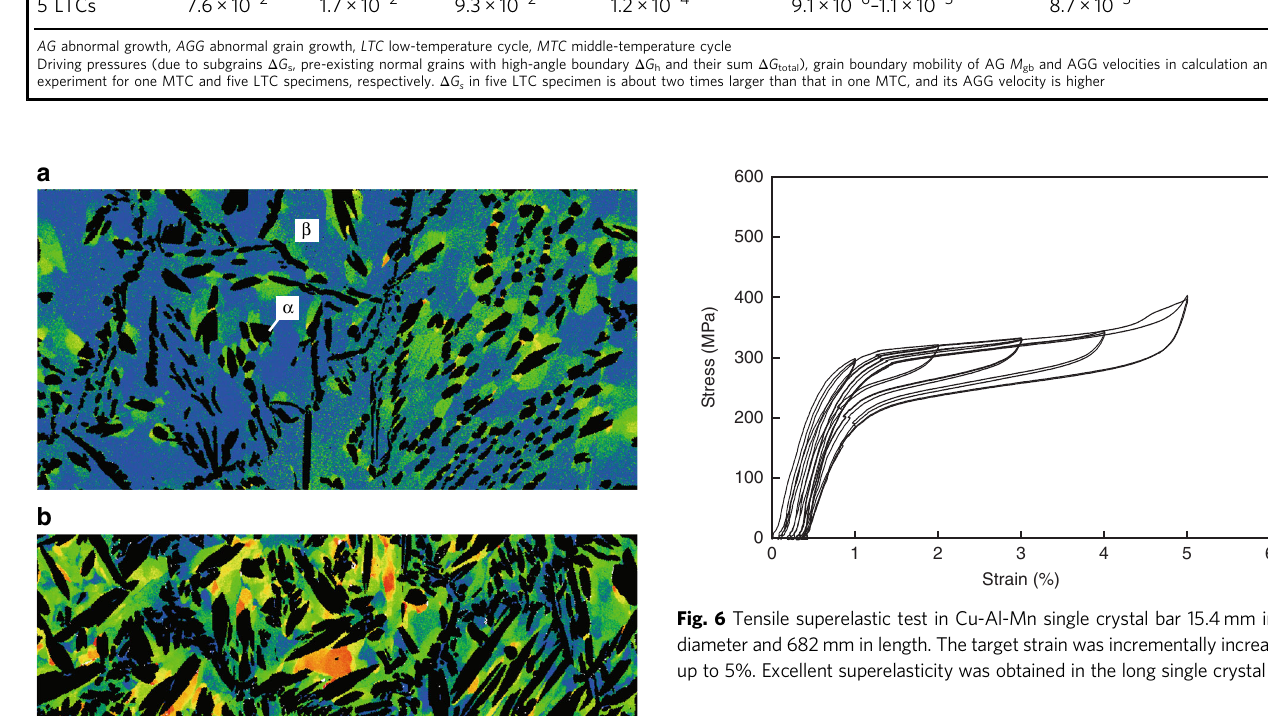
of 2mm and subsequent cold-rolling to a thickness of 1mm with intermediate annealing at 600°C. Bar specimens were obtained by hot forging and cold drawing to a diameter of 15mm. The β solidus and α solvus temperatures of this alloy were determined to be 948 and 726°C, respectively, by means of differential scanning calorimetry (DSC). The sheet specimens were solution- treated at 740 – 900°C for 5 – 15min in the β single-phase region. They were cooled to 500°C in the α + β two-phase region at a cooling rate of 3.3°Cmin − 1 and held for 10min at 500°C, and then heated to 760 – 900°C at a heating rate of 10°Cmin − 1 and held for various periods, followed by quenching in water. Some specimens were subjected to CHT between 740 and 500°C fi ve times, instead of the single CHT, before heating to the β single-phase region. The procedure of heat treatment of the bars and sheets is illustrated in Fig. 1 and Supplementary Fig. 4. Microstructural observation . The microstructure and the crystallographic features were investigated by optical microscopy and EBSD using a fi eld emission scanning electron microscope. Method of determination of misorienta- tion angle between subgrains is shown in Supplementary Fig. 1, and the accuracy of misorientation angle 45, 46 is discussed in Supplementary Discussion.